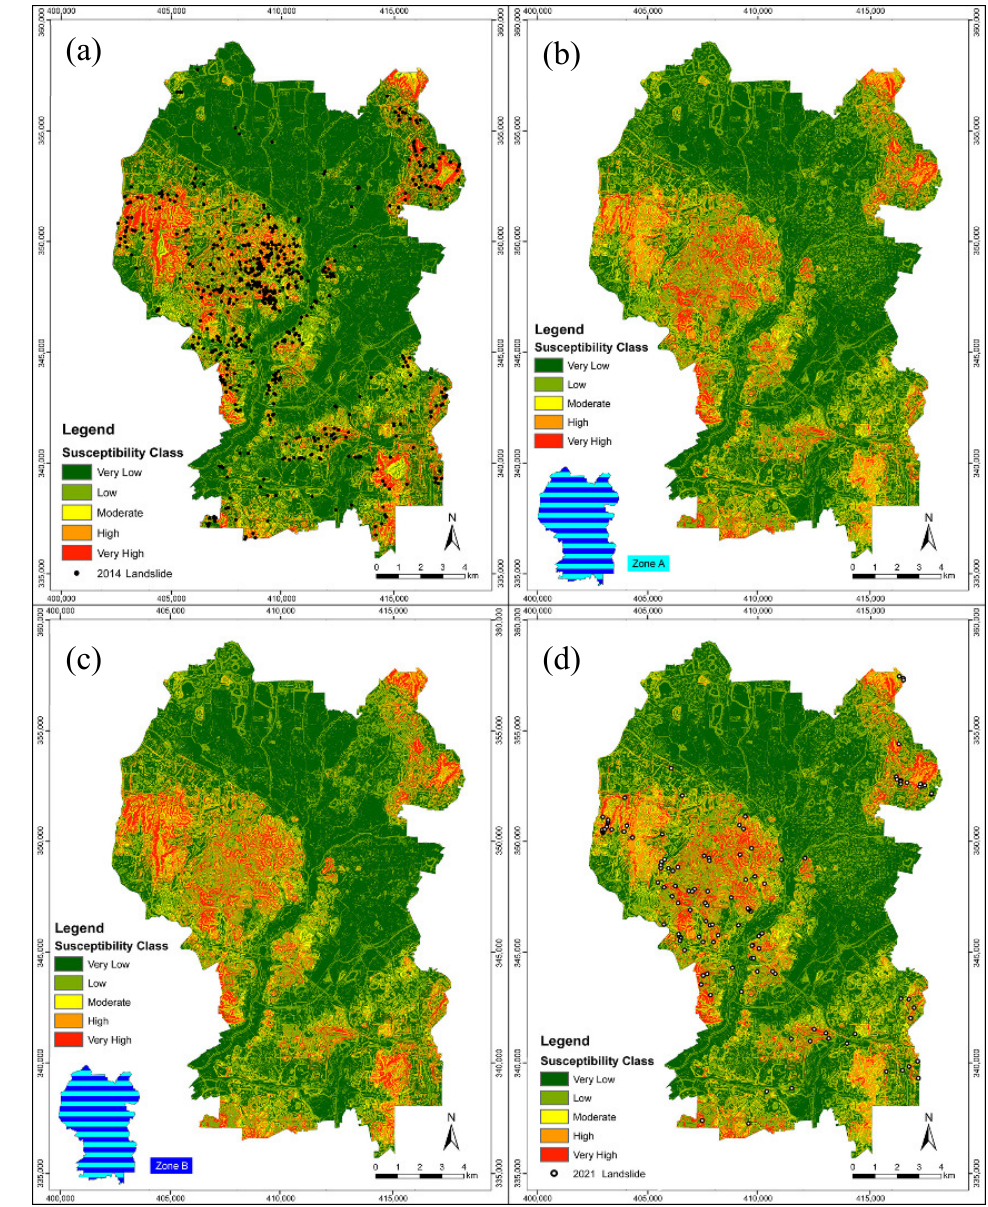
Figure 4. ( a ) Landslide susceptibility map of model 1, where all the landslide points in the 2014 inventory were used to generate the model. ( b ) Landslide susceptibility map of model A, where landslides in zone A were used as training dataset and landslides in zone B as test dataset. ( c ) Land- slide susceptibility map of model B where landslides in zone B were used as training dataset and landslides in zone A as test dataset. ( d ) Landslides occurred in 2021 that were used for retrospective validation are plotted on model A.